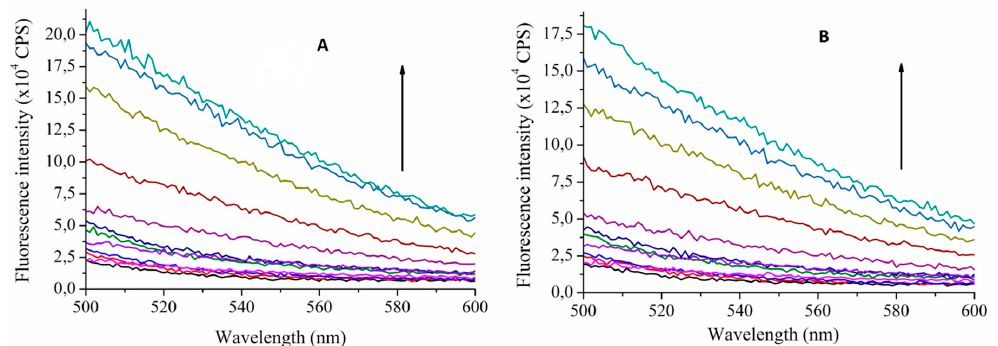
Figure 3. Fluorescence emission spectra of MTX (10 µM) in the absence and presence of TAC (0–80 µM) at 393.15 K ( A ) and at 313.15 K ( B ) ( λ excitation = 390 nm). Arrows indicate increasing TAC concentrations (CPS reflects counts per s, colors only support the clarity).